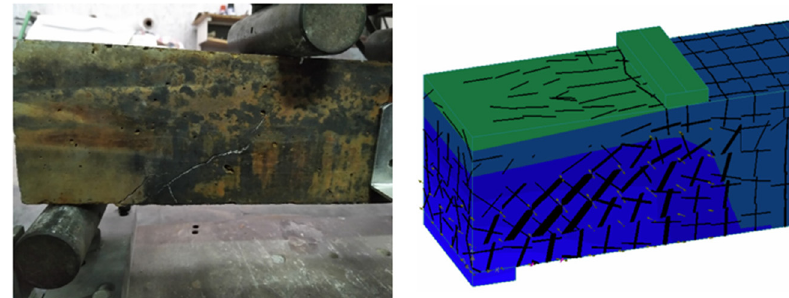
Figure 18: Comparison of crack distribution between experimental and FE model.